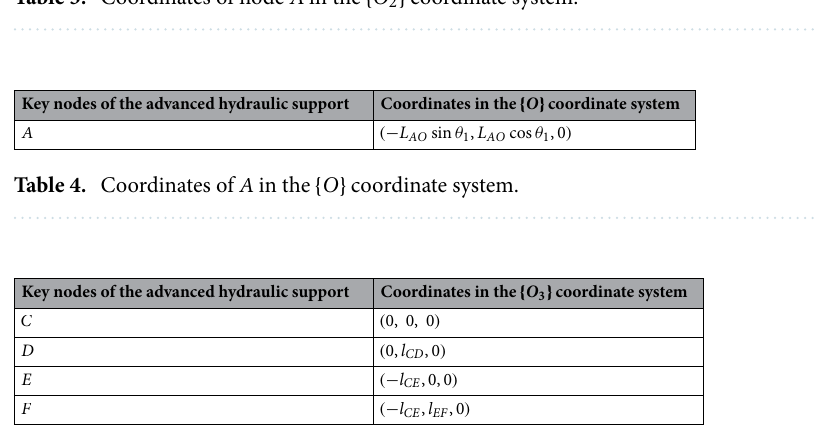
Table 3. Coordinates of node A in the { O 2 } coordinate system.